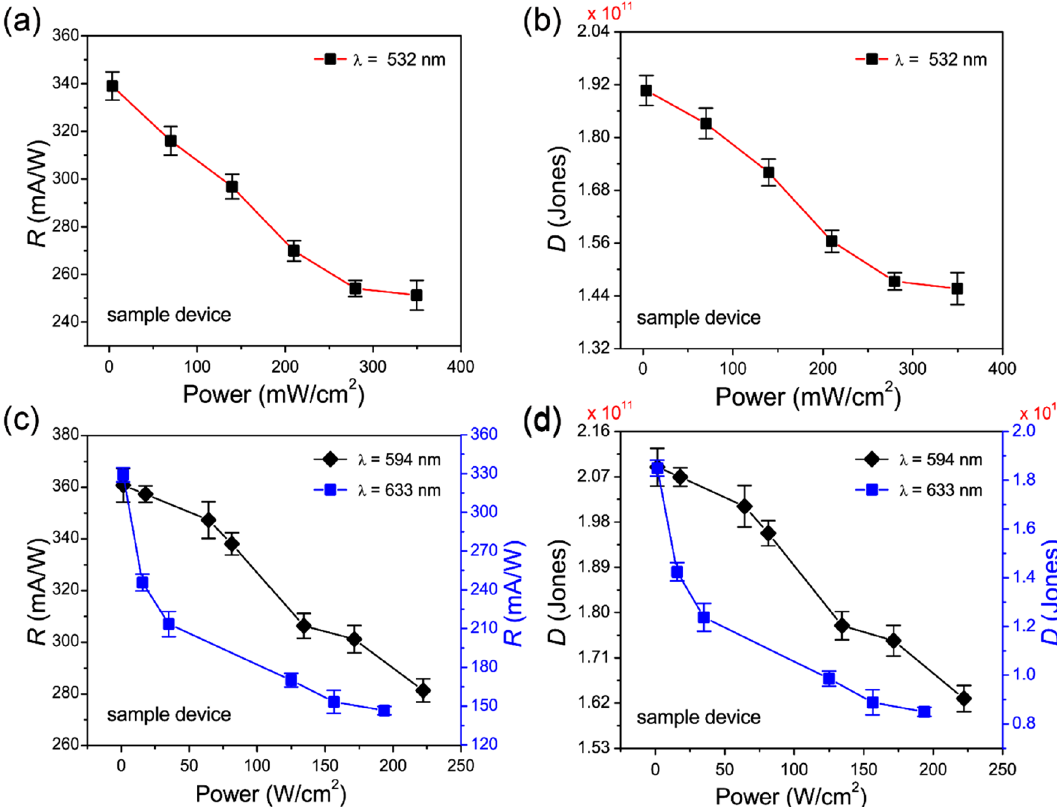
Figure 5. Responsivity R ( a ) and detectivity D, ( b ) of the perovskite photodiode with the NiO x HTL as a function of the input power of incident light (532 nm) at zero bias voltage, and comparison of the responsivity R, ( c ) and detectivity D, ( d ) of the photodiode as a function of the input power of incident light with different wavelengths (594 and 633 nm) at zero bias